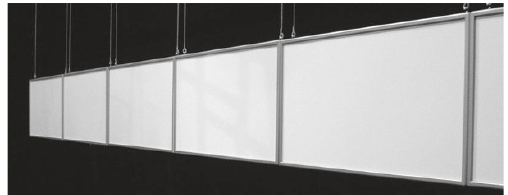
Figure 10: MAP loudspeakers.